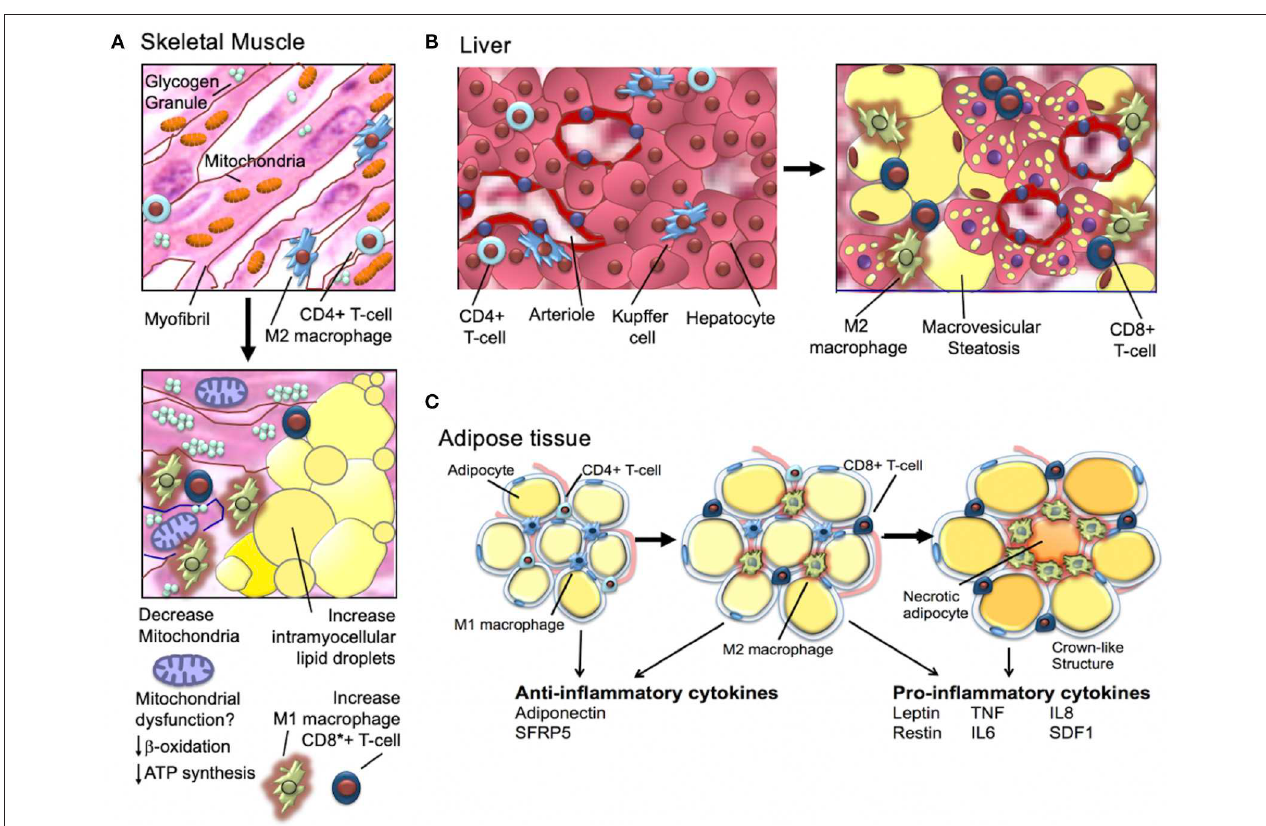
FIGURE 5 | Hyperinsulinemia and (A) skeletal muscle, (B) liver, and (C) adipose